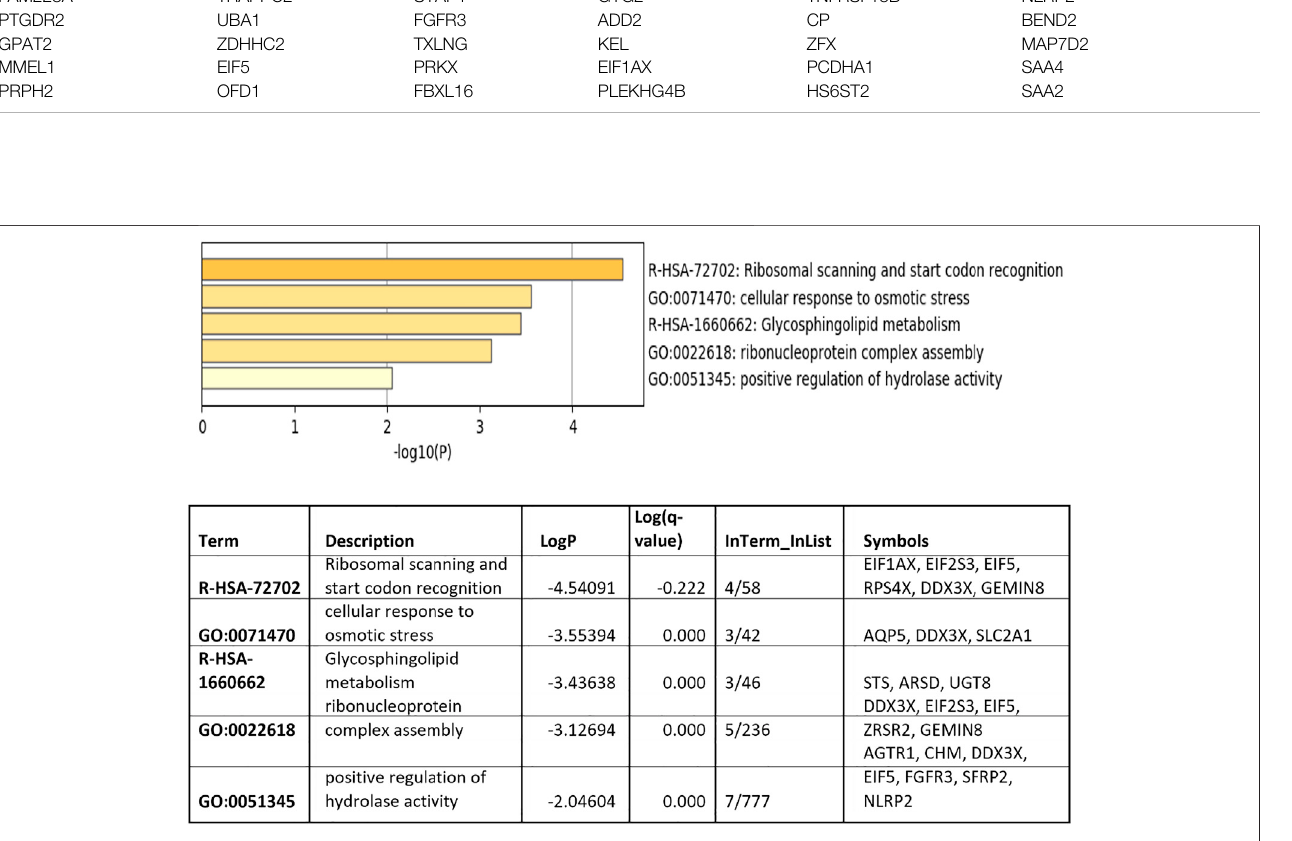
Frontiers in Molecular Biosciences |